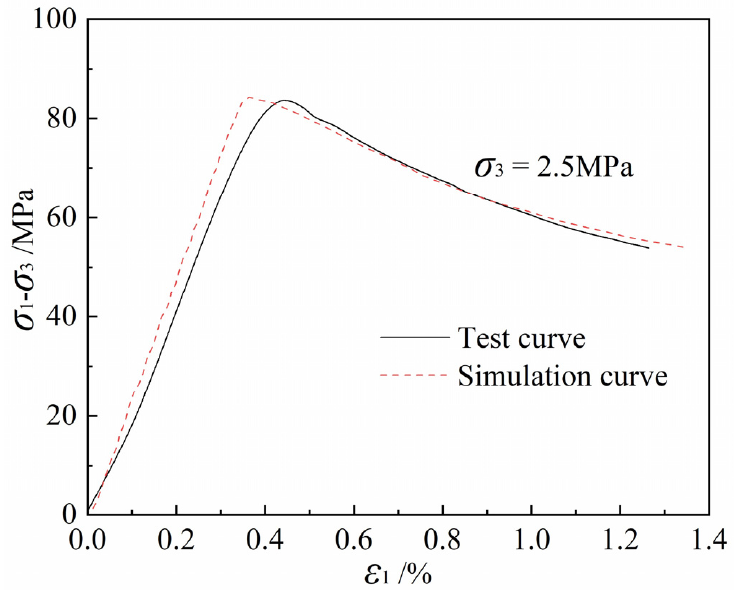
Figure 11. Comparison of simulated and experimental stress–strain curves (RAC20, confining pressure 2.5 MPa).